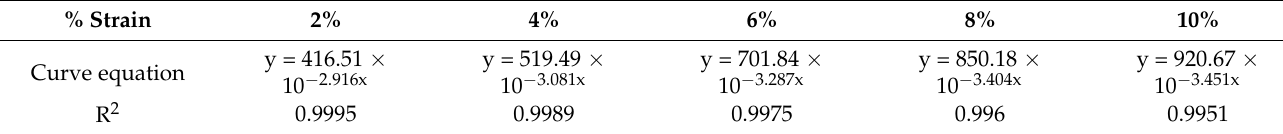
Table A7. Significant difference in conductivity between various Slacker concentrated groups. A Table A8. Equations and R 2 values for individual curves in Figure 3. significant difference was indicated with O and an insignificant difference was indicated with x.